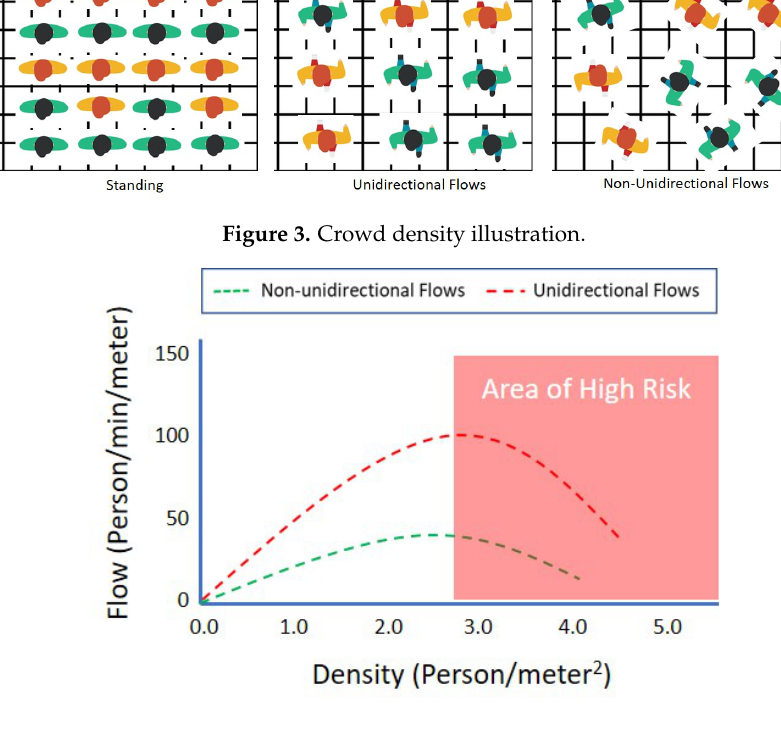
Figure 4. Mobile crowd density vs.